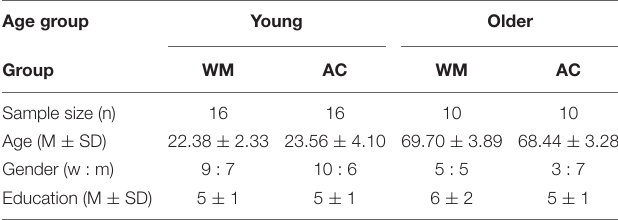
TABLE 1 | Participants demographics as a function of